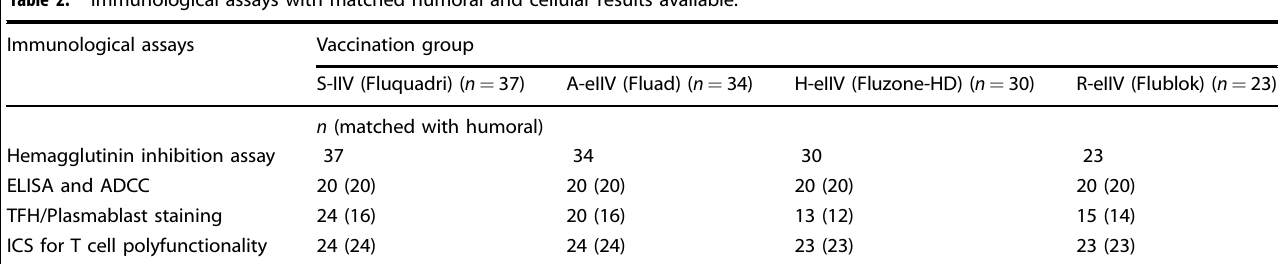
Table 2. Immunological assays with matched humoral and cellular results